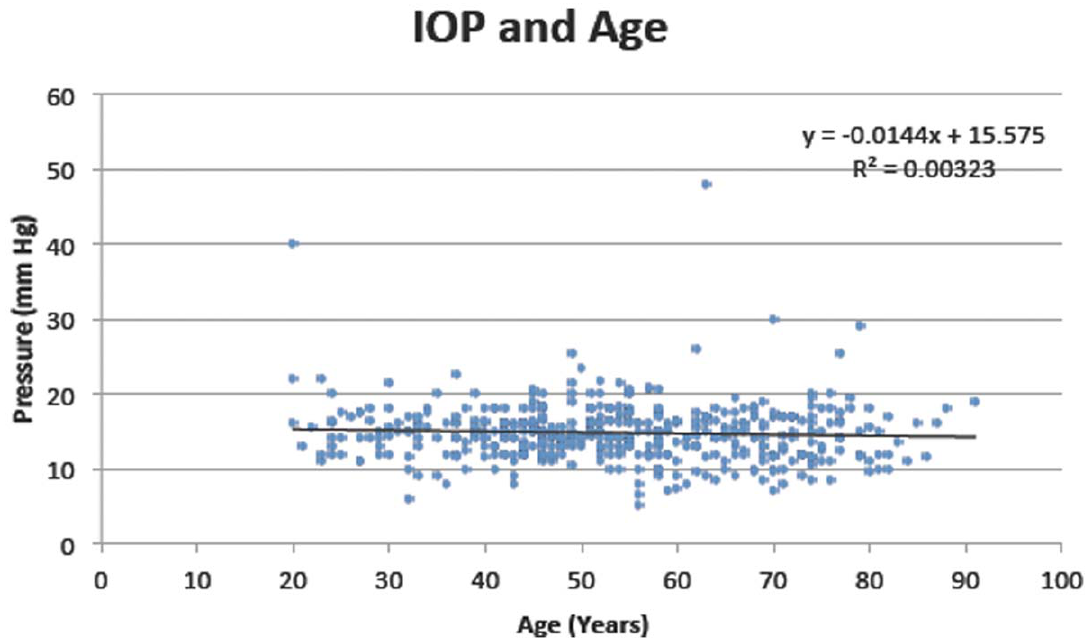
Figure 3. Average intraocular pressure against age. Formula for the regression: y= 2 0.0144 6 + 15.575, r 2 =0.003.